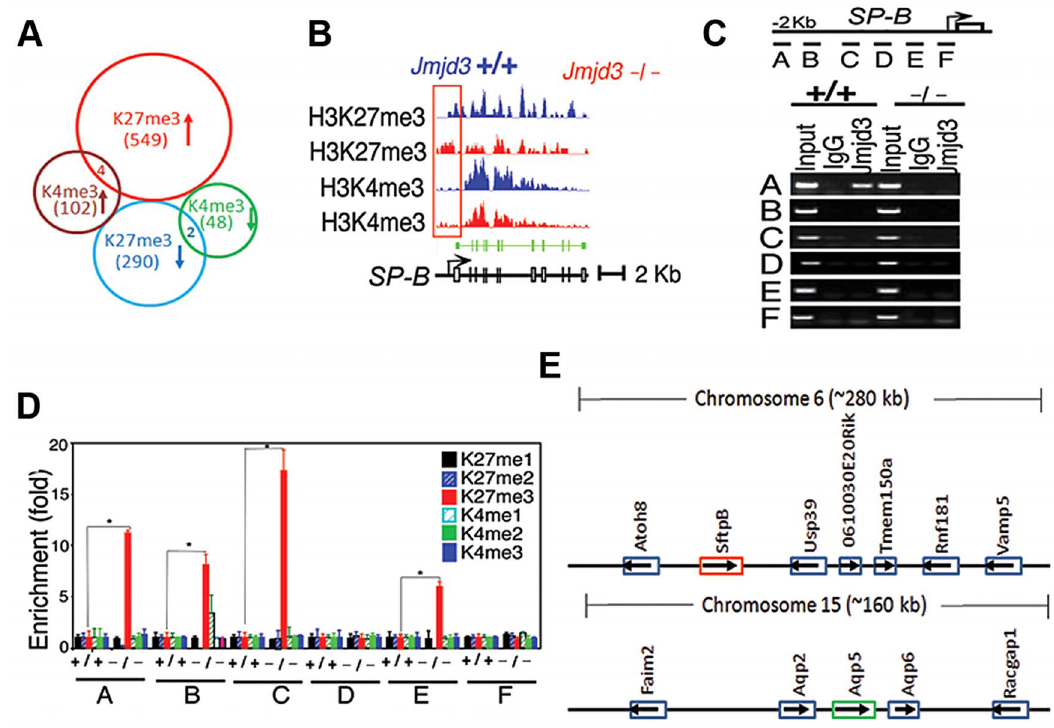
Figure 5. Jmjd 3 ablation affects global histone methylation in lung tissues and methylation status of the promoter regions of target genes. ( A ) Global gene methylation analysis of Jmjd3 + / + and Jmjd3 2 / 2 lung tissues at E17.5 by ChIP-Seq. q , methylation increased; Q , methylation decreased. ( B ) ChIP-Seq analysis of H3K27me3 and H3K4me3 levels in the promoter and gene body regions of the SP-B gene in Jmjd3 + / + and Jmjd3 2 / 2 lung tissues at E17.5. Data shown are representative of three independent experiments. ( C ) Jmjd3 binding to the SP-B promoter in lung tissues was determined by ChIP-PCR. Chromatin was immunoprecipitated from the lung tissues of E17.5 Jmjd3 + / + and Jmjd3 2 / 2 embryos. Primer design for the ChIP-PCR assay of mouse SP-B promoter regions ( top panel ). The primers sets cover the following regions: A, 2 2347– 2 2142; B, 2 2065– 2 1835; C, 2 1451– 2 1334; D, 2 1001– 2 878; E, 2 516– 2 383; F, 2 218– + 14. ChIP-PCR assay showing Jmjd3 binding around 2 kb upstream of the TSS of the SP-B promoter region ( bottom panel ). ( D ) ChIP-qPCR analysis of histone methylation levels in the SP-B promoter region in the lung tissues of E17.5 Jmjd3 + / + and Jmjd3 2 / 2 embryos. ( E ) Locus-specific demethylation analysis of Jmjd3 by ChIP-Seq. ChIP-Seq was done to determine the H3K27 and H3K4 methylation level of genes located in the region ( , 280 kb) containing SP-B on chromosome 6 and the region ( , 160 kb) containing AQP-5 on chromosome 15. Arrows indicate the gene expression direction.